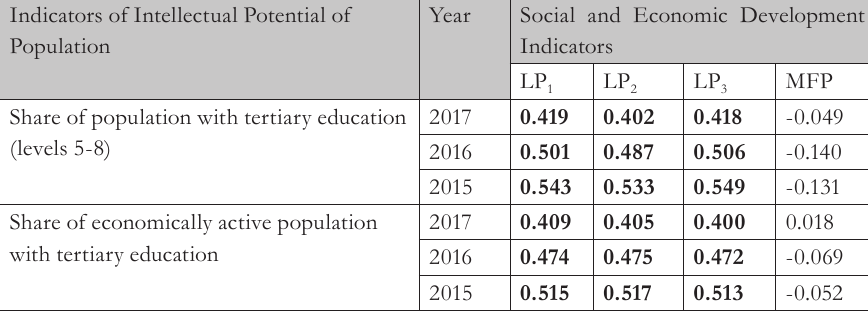
Tab. 1 – Correlation coefficients of the relationship between human intellectual potential and key social and economic development indicators in EU member states for 2015 – 2017 Source: calculations based on data from Eurostat, 2019a-j Indicators of Intellectual Potential